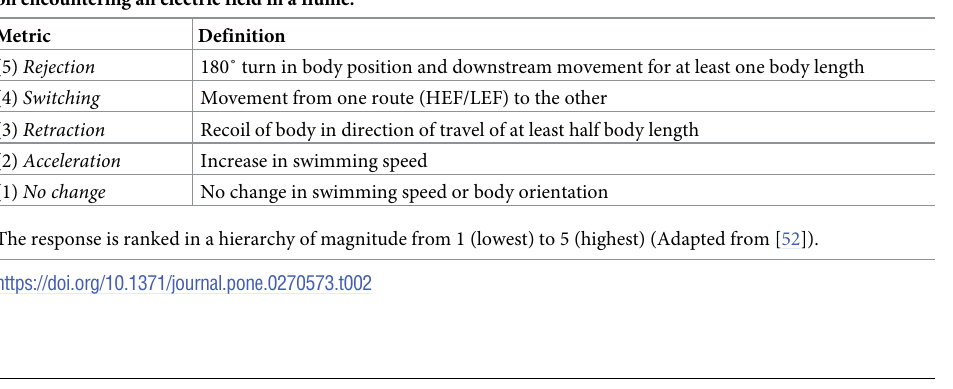
Table 2. Definitions of different categories of avoidance behaviours exhibited by upstream migrating juvenile eel on encountering an electric field in a